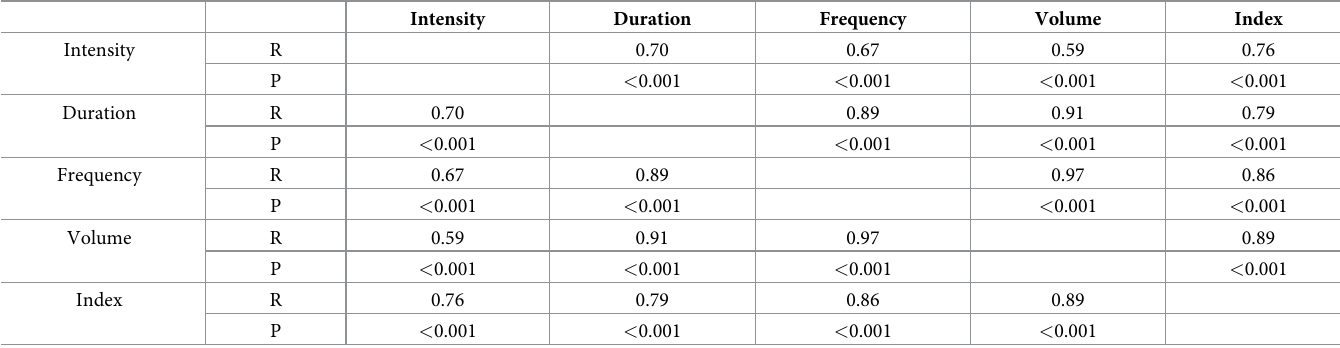
Table 3. Correlations between intensity, duration, frequency, volume and index.